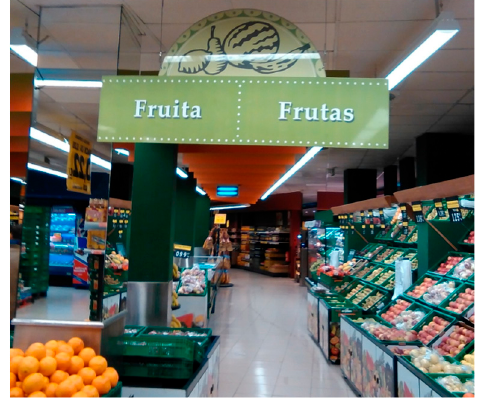
Figure 38. Valencia: Bilingual sign in a supermarket .